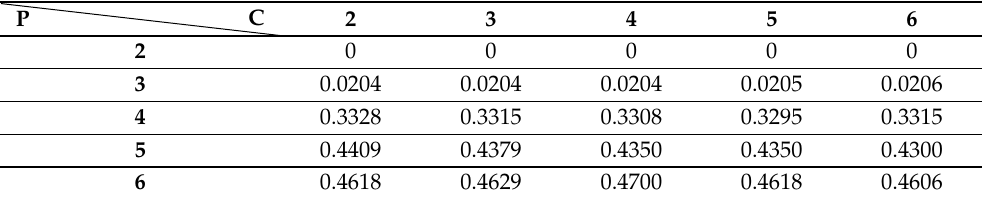
Table 3. Performance index of CGK-GM that created context evenly.